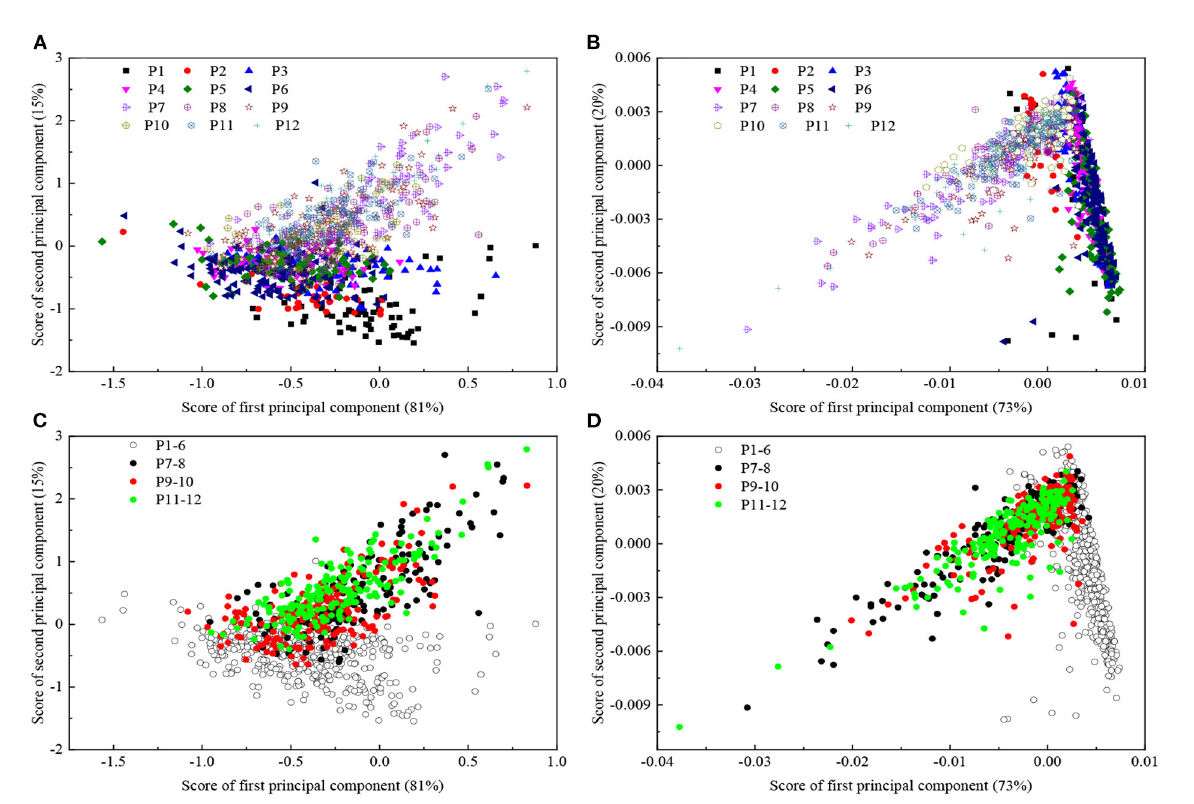
FIGURE5 Plots of principal component analysis score for absorption (A,C) and 2D spectra (B,D) . P1–6, P7–8, P9–10 and P11–12 were illustrated using open white circles with black contour, black closed circles, red closed circles and green closed circles in panel (C,D) . P represented